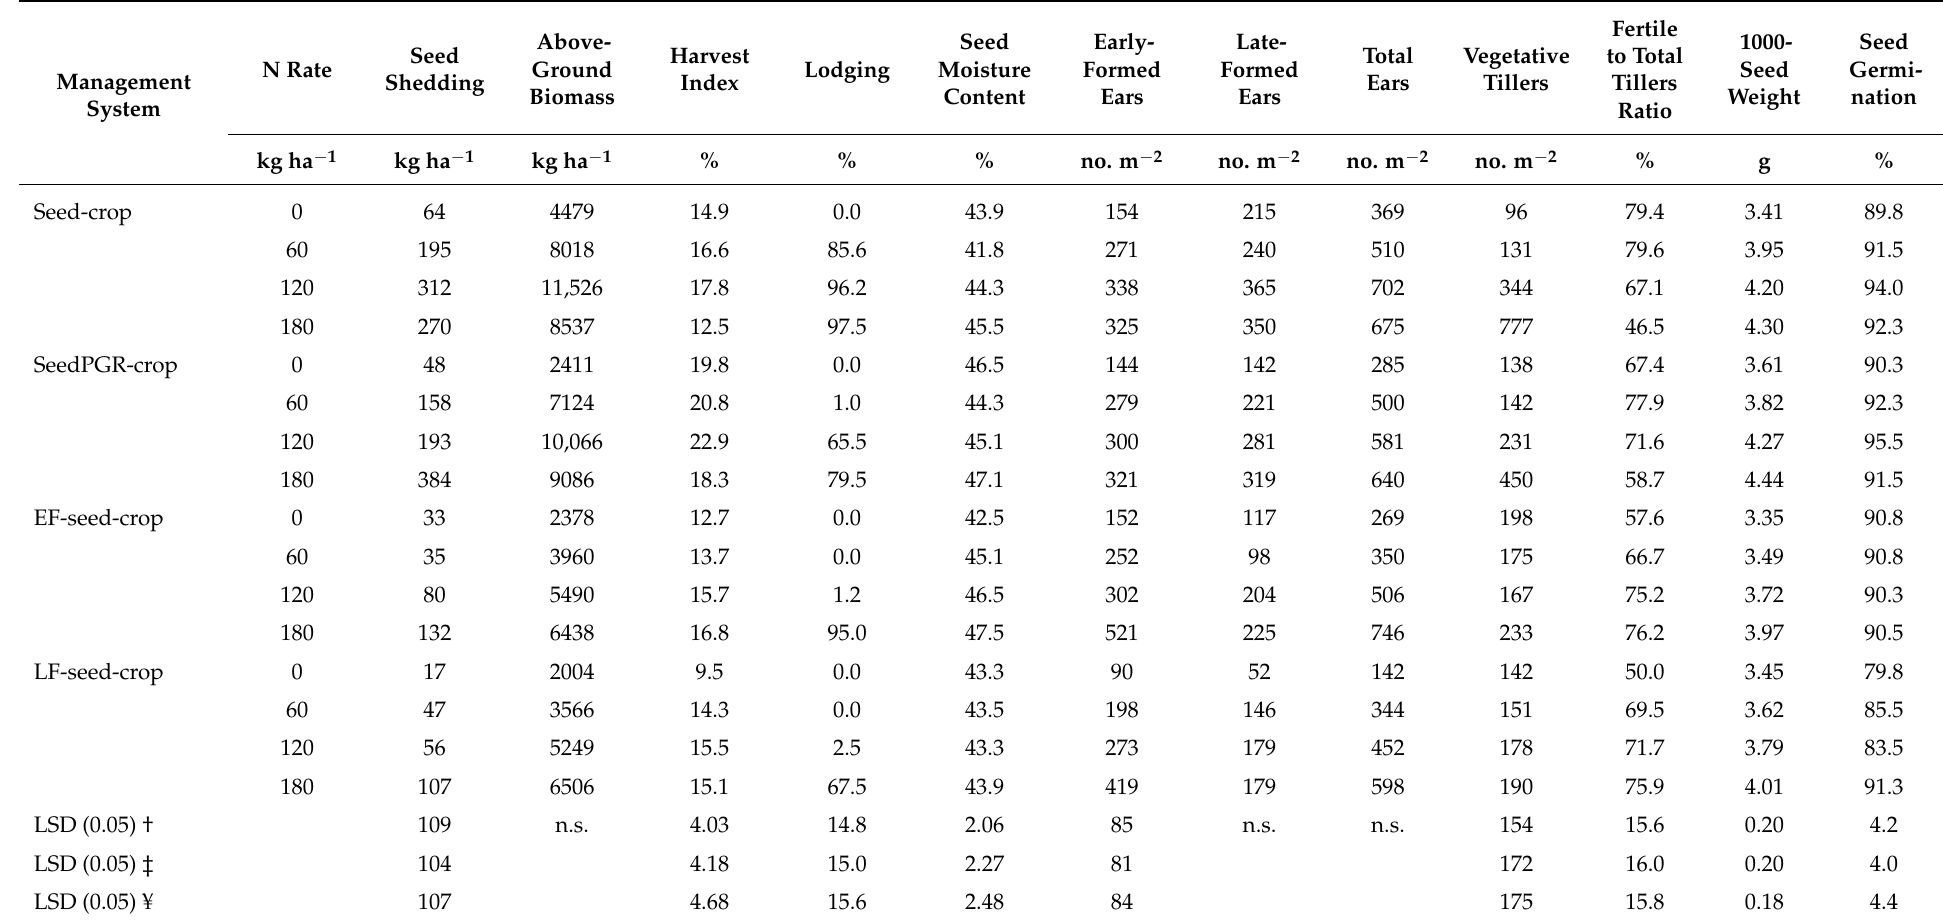
Table 4. Seed shedding, above-ground biomass, harvest index, yield components, and other traits of the second-year Italian ryegrass crop grown under various management systems and nitrogen (N) fertilization